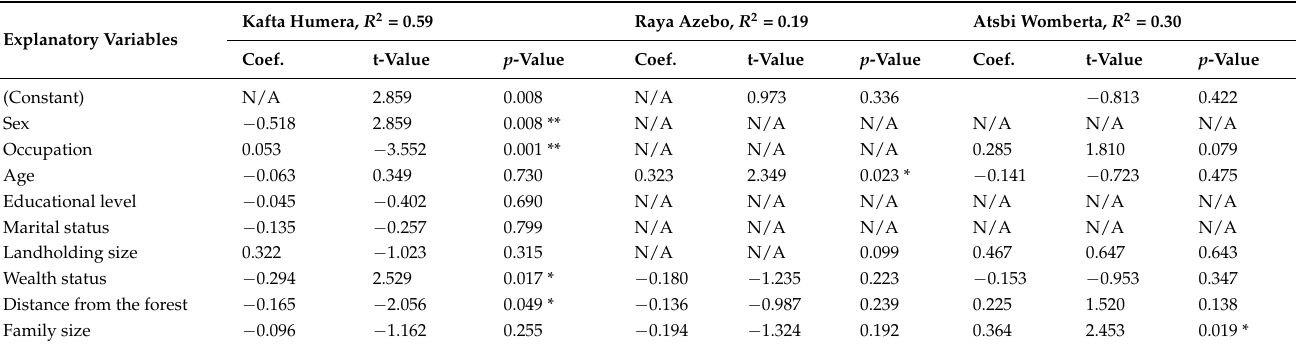
Table 7. Household-level socioeconomic variables influencing level of dry forest